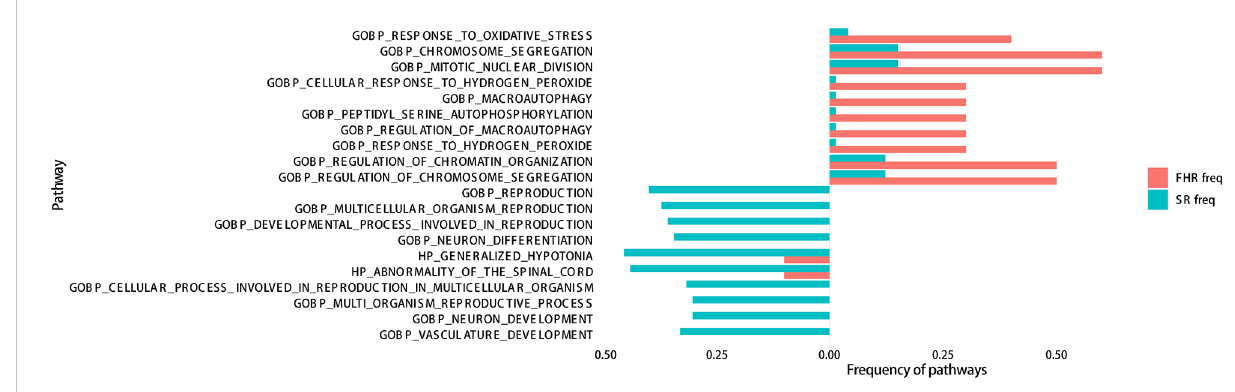
FIGURE 4 GO enrichment of the top 20 genes in FHR and SR groups analyzed by Fisher ’ s